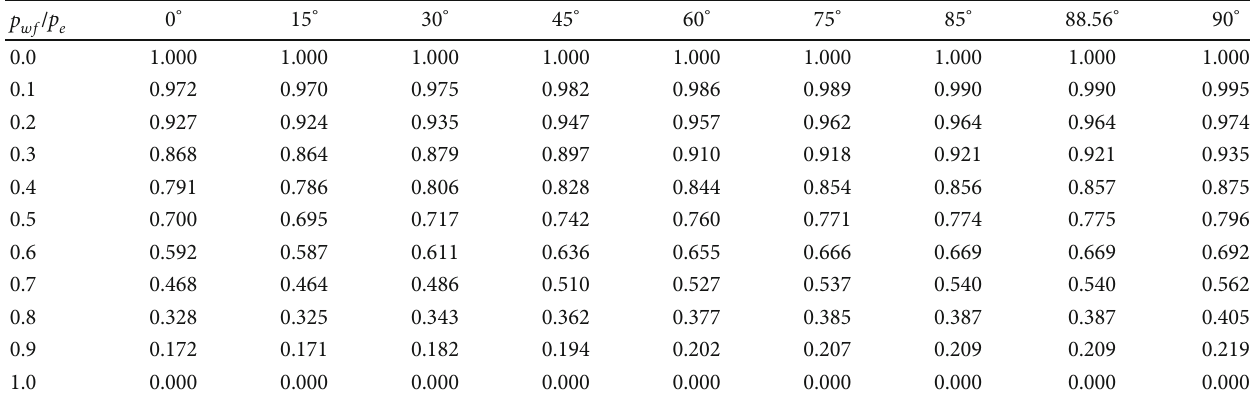
Table 2: Average normalized dimensionless production of di ff erent well inclination angles